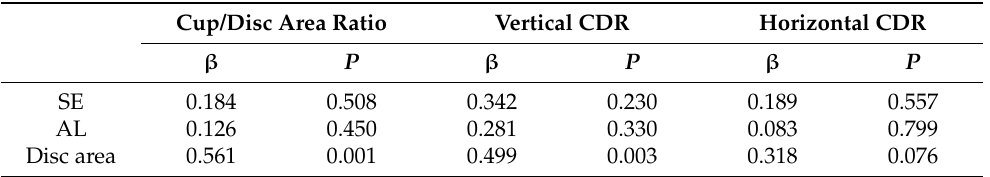
Table 4. Factors associated with cup/disc area ratio, vertical CDR, and horizontal CDR (multiple linear regression analysis).